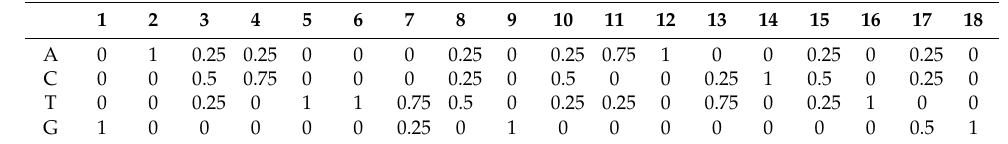
Table 1. Position Weight Matrix for a